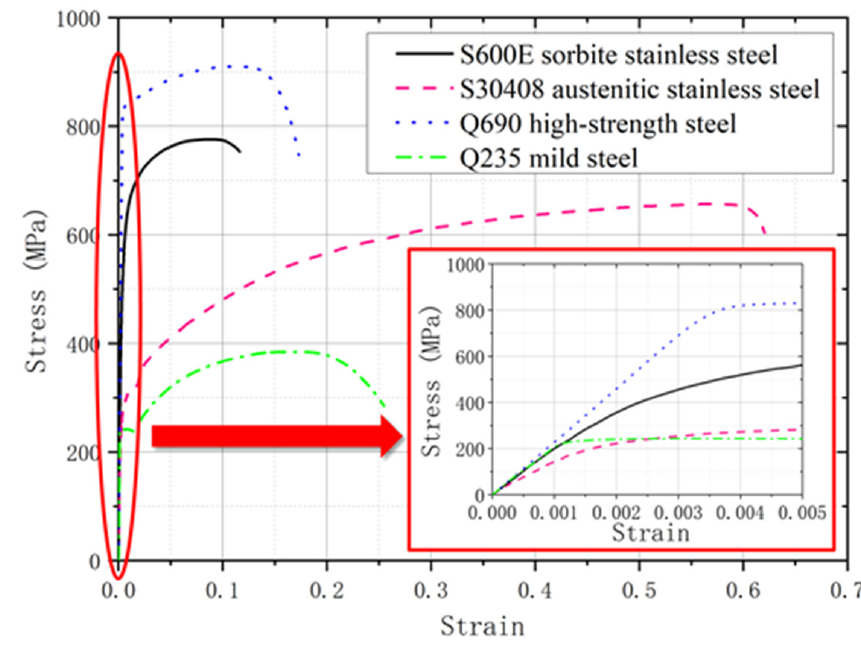
Figure 3. Comparison in stress–strain curves between stainless steel and carbon steel [27,29]. Table 1. Chemical composition of different structural steels (wt. %).